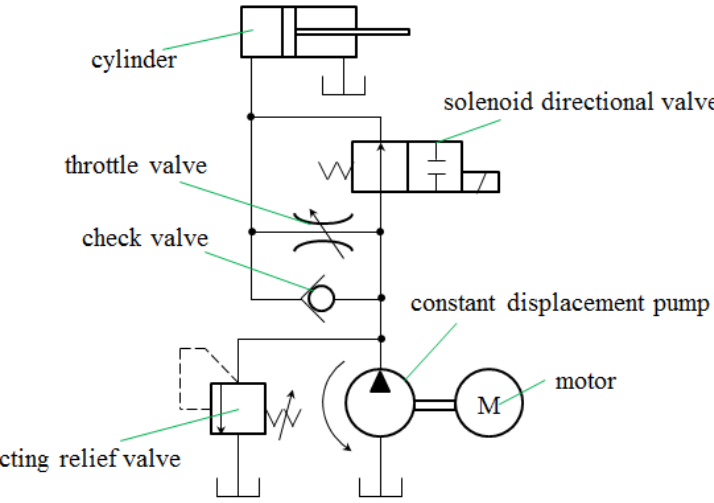
Figure 1. Constant pressure relief circuit of inlet throttle speed-control system.